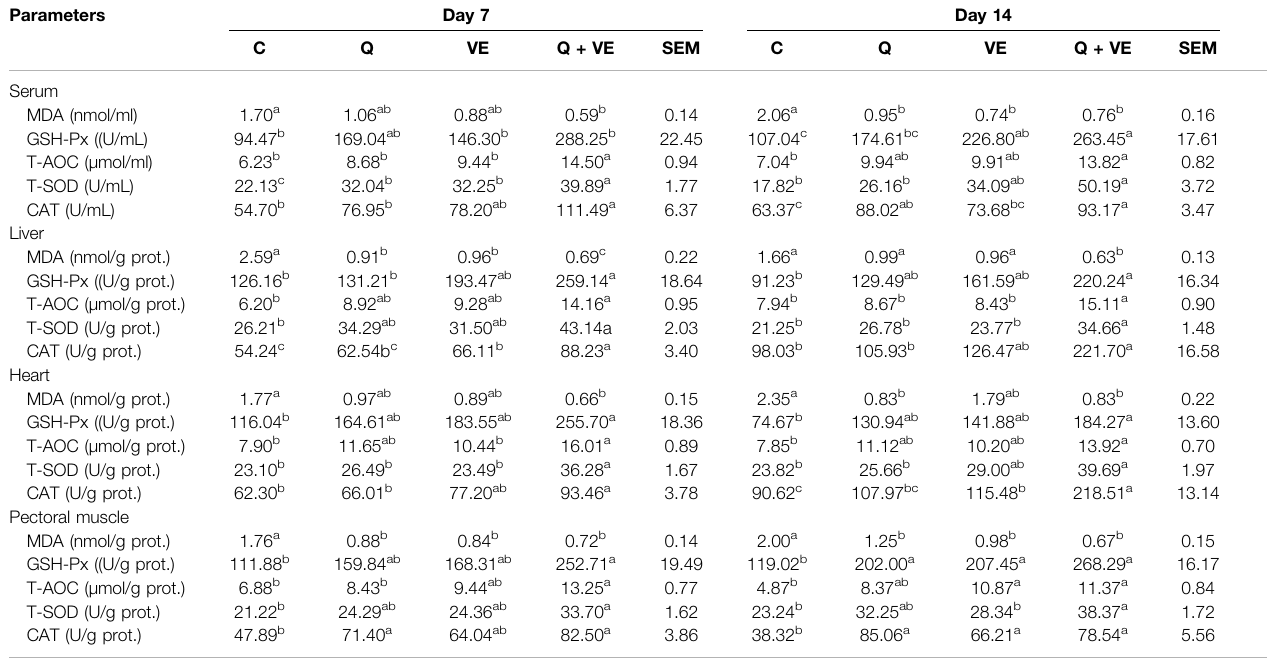
TABLE 7 | Dietary effects of Q, VE, and Q + VE on the antioxidant status of the 1-day-old chicks. Parameters Day 7